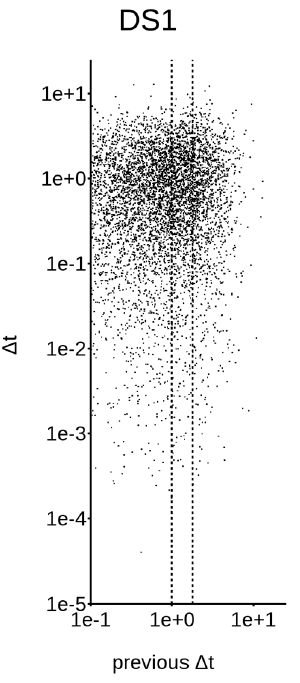
Figure 4. Example of how events are selected to compute the new survival probability functions depending on the previous ∆ t .